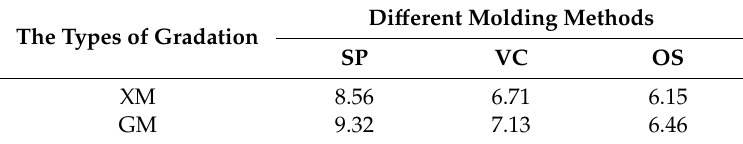
Table 10. The reconstructed void (%) of di ff erent molding